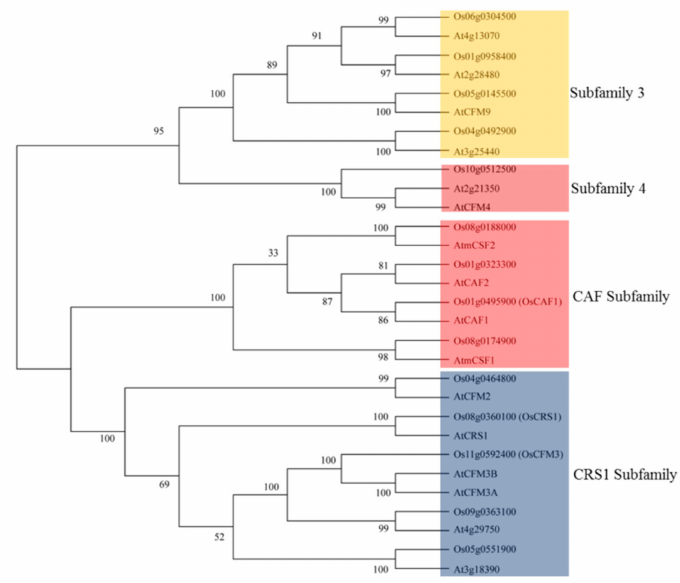
Figure 1. Structural analysis of CRM genes’ family. Yellow and blue boxes indicate coding sequences and upstream or downstream untranslated regions, respectively. Black lines indicate introns. The scale bar at the bottom shows the length of the CRM genes in Kb.